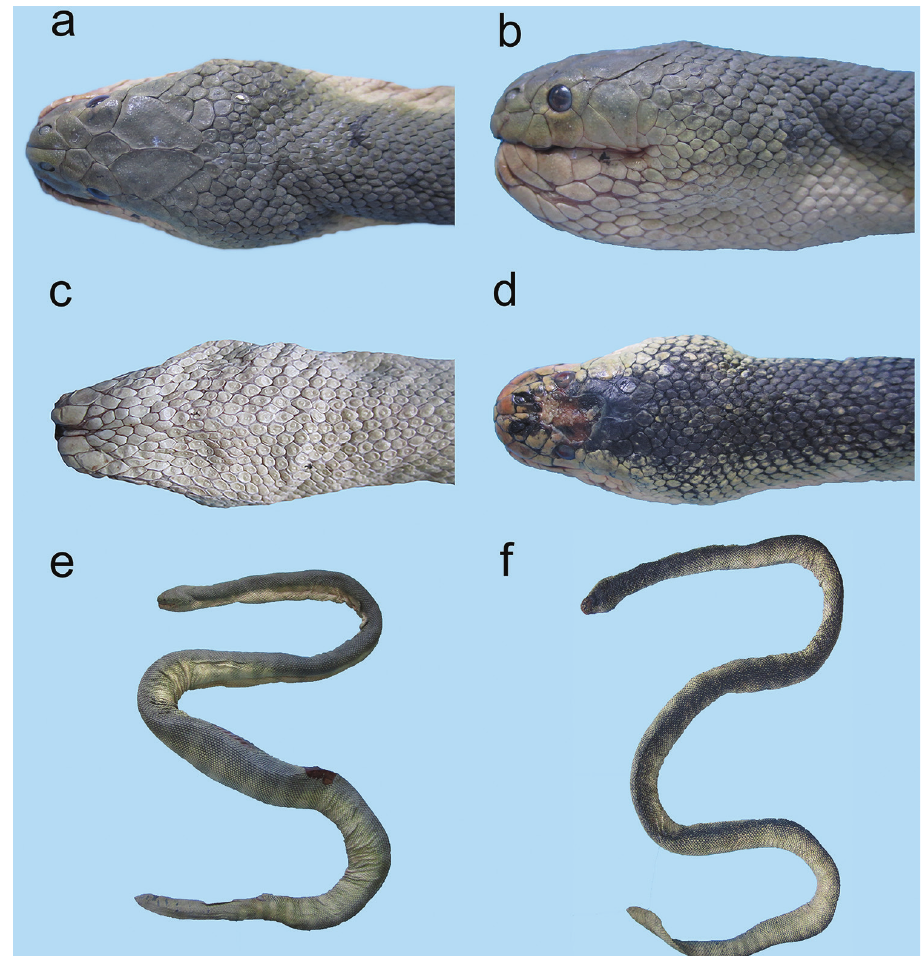
Figure 6. Hydrophis schistosus : a dorsal view b lateral view, and c ventral view of head d dorsal view of head of a black specimen e typical body color f black